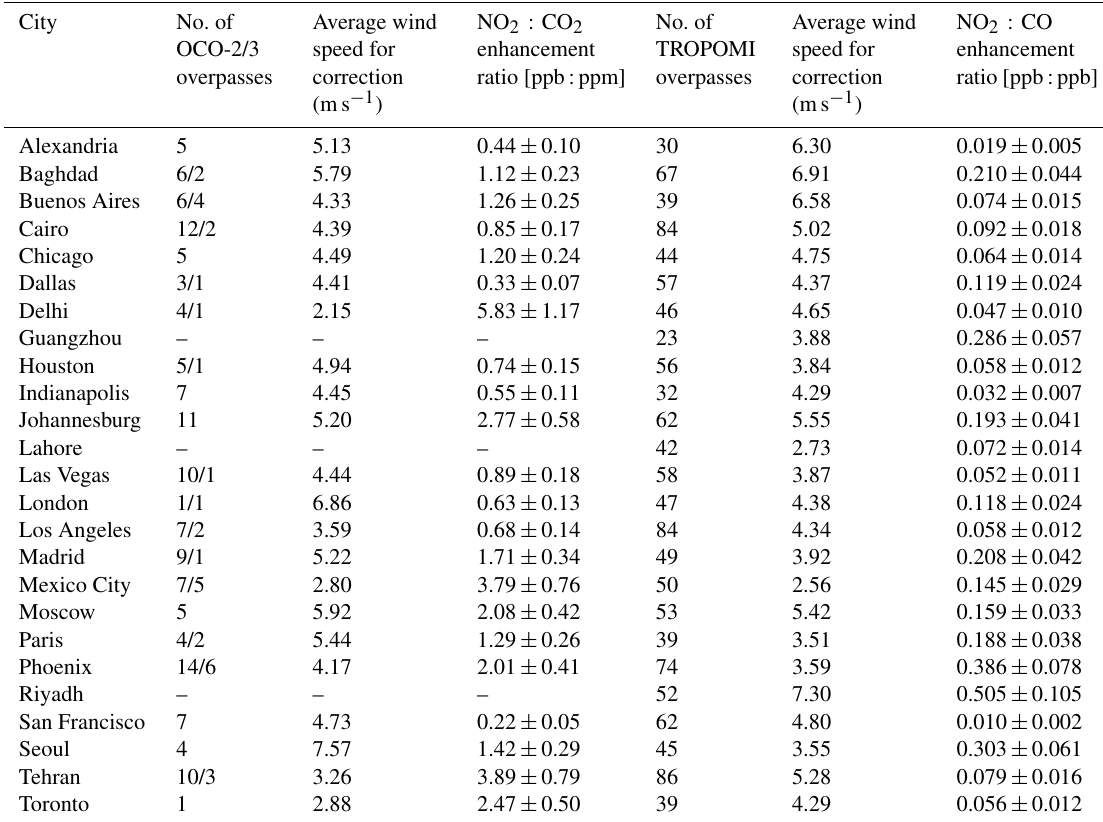
Table 3. All NO 2 : CO 2 and NO 2 : CO enhancement ratios derived using OCO-2/3 and TROPOMI, including the NO 2 lifetime correction. Overpasses must individually have sufficient linear dependence ( R > 0 . 2). Cities without any such overpasses are marked by a